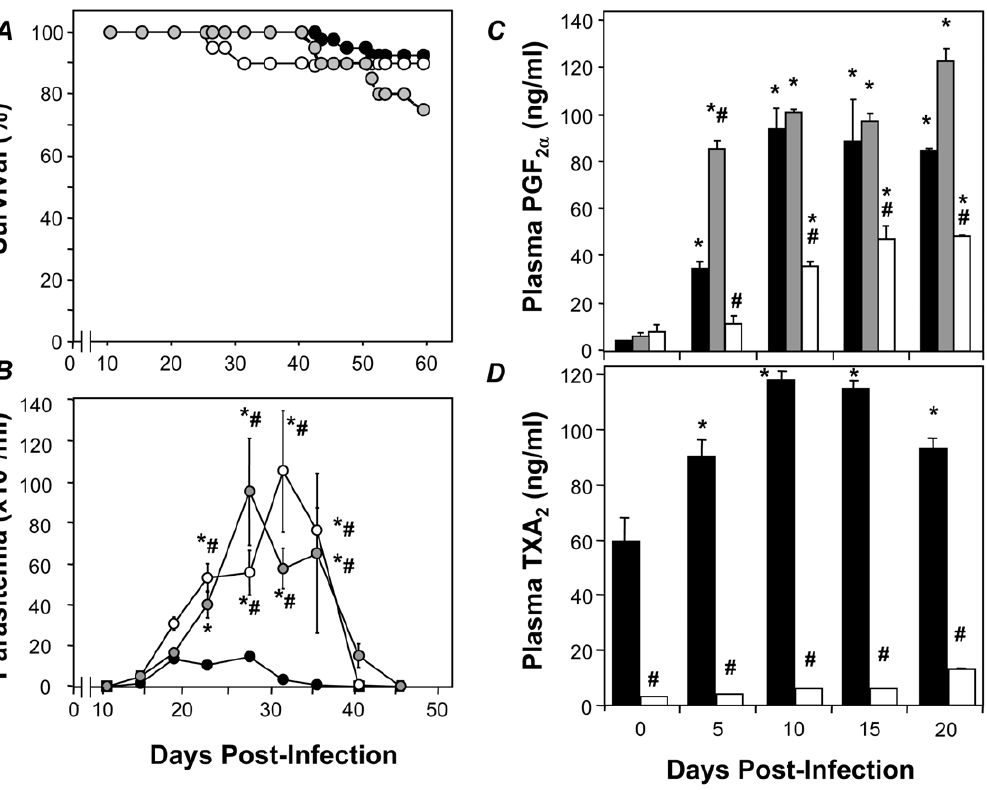
Figure 5. Deletion of COX-1 mimics the effects of ASA on parasitemia but not survival in T.cruzi infected mice. A and B . Survival curves ( A ) and peripheral parasitemia ( B ) for WT (black circle), TXA 2 synthase null mice (grey circle) and COX1 null mice ( # ) mice after inoculation with 10 5 trypomastigotes of the Brazil strain. C and D . Measurement of plasma PGF 2 a ( C ) and TXB 2 ( D ) in infected WT (black square), TXA 2 synthase null mice (grey square) and COX-1 null mice (white square) mice. Data are represented as mean 6 SD are representative of at least 20 mice per group. * and # indicates significance ( P # 0.05) from uninfected and infected WT mice, respectively.